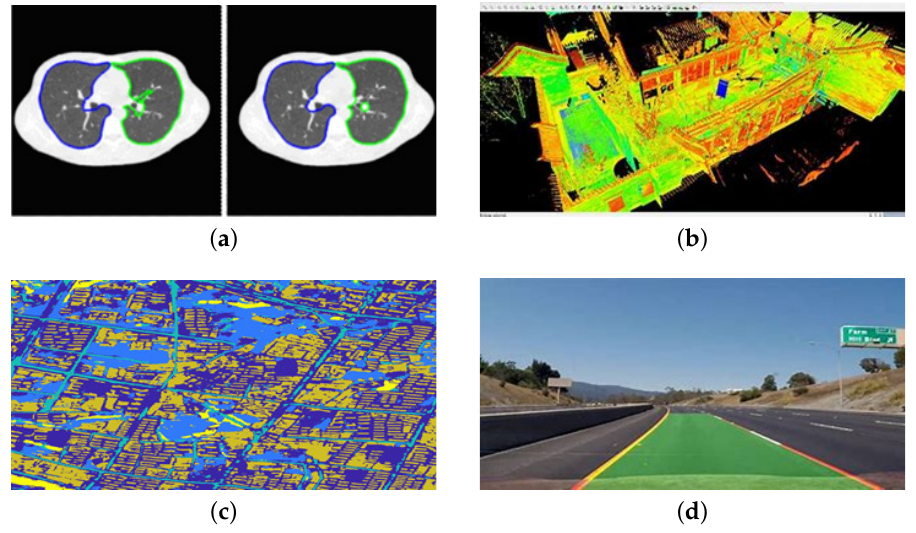
Figure 1. Examples of areas where semantic segmentation can be used. ( a ) Medical image; ( b ) 3D point clouds image; ( c ) Remote sensing image; ( d ) Lane mark detection